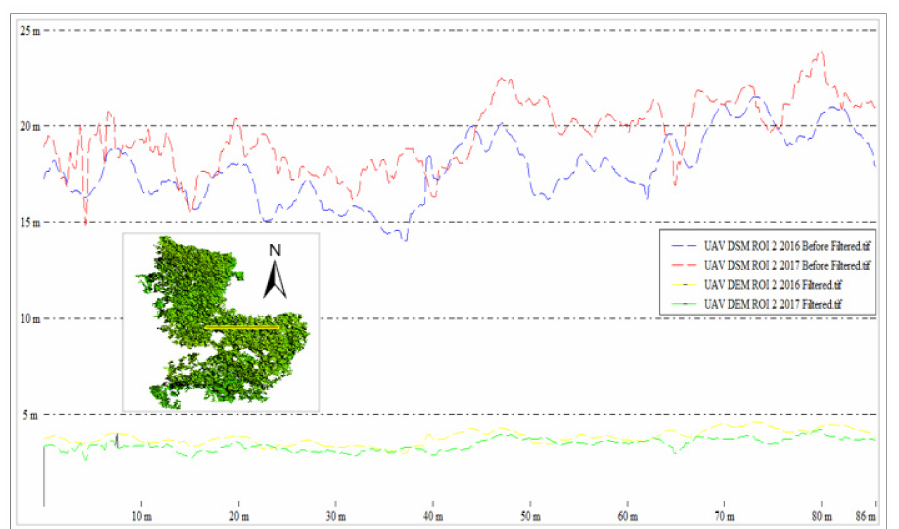
Figure 7. Profile line comparison between unfiltered and filtered DEM at low tide at ROI 2 in 2016 and